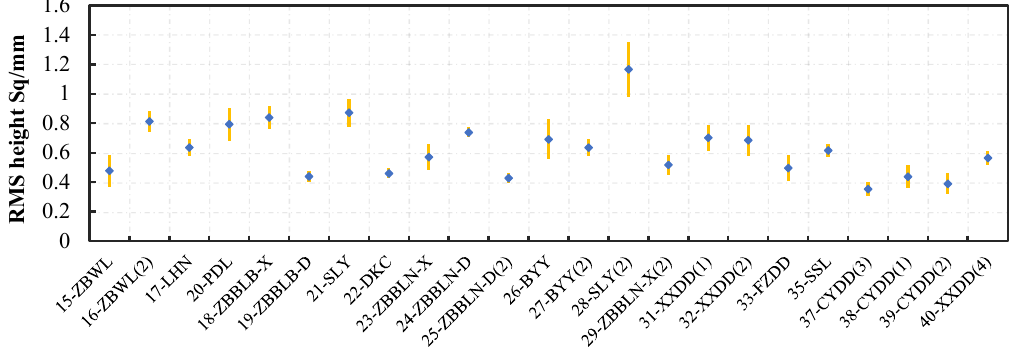
Figure 12. Parameter S q of the pavement in different test sections.